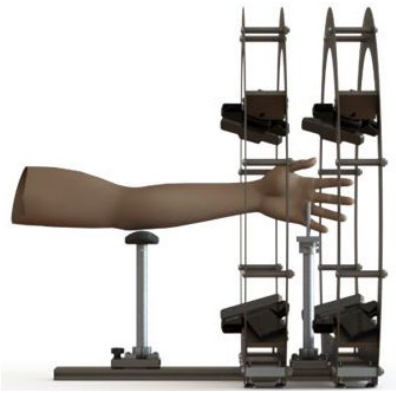
Figure 1. Layout of the instant hand wrist arm 3D scanner.